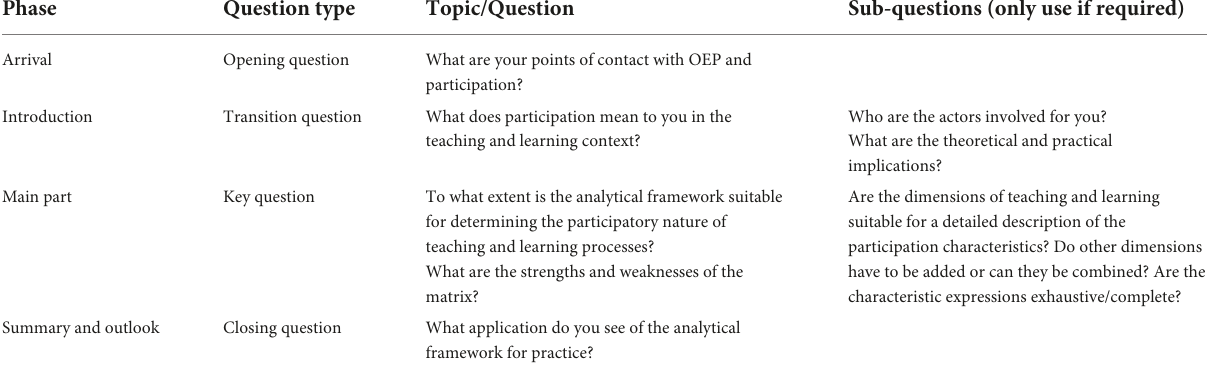
TABLE 4 Guiding questions in focus group